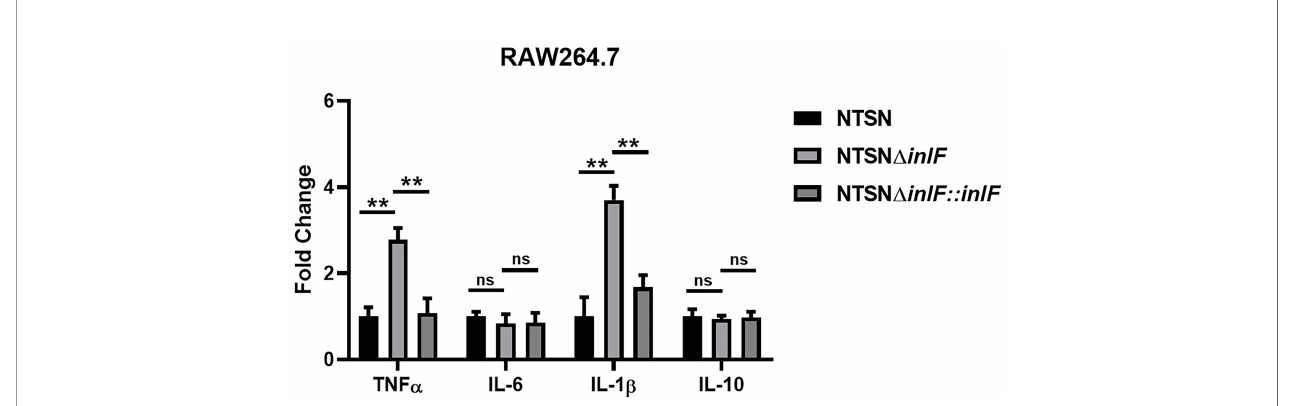
FIGURE 3 | InlF impairs the proin fl ammatory response in vitro. RAW264.7 cells were infected (MOI = 20) with Lm NTSN NTSN D inlF and NTSN D inlF::inlF . The determination was performed 1h of bacteria invasion. Among them, the PBS negative control group is represented by horizontal line bar, NTSN is represented by black and white check bar and the mutant is represented by black dot bar. Values are mean with error bars; n = 3 independent experiments. Statistical analysis was carried out by Tukey ’ s multiple comparisons test: **P < 0.01, ns, no signi